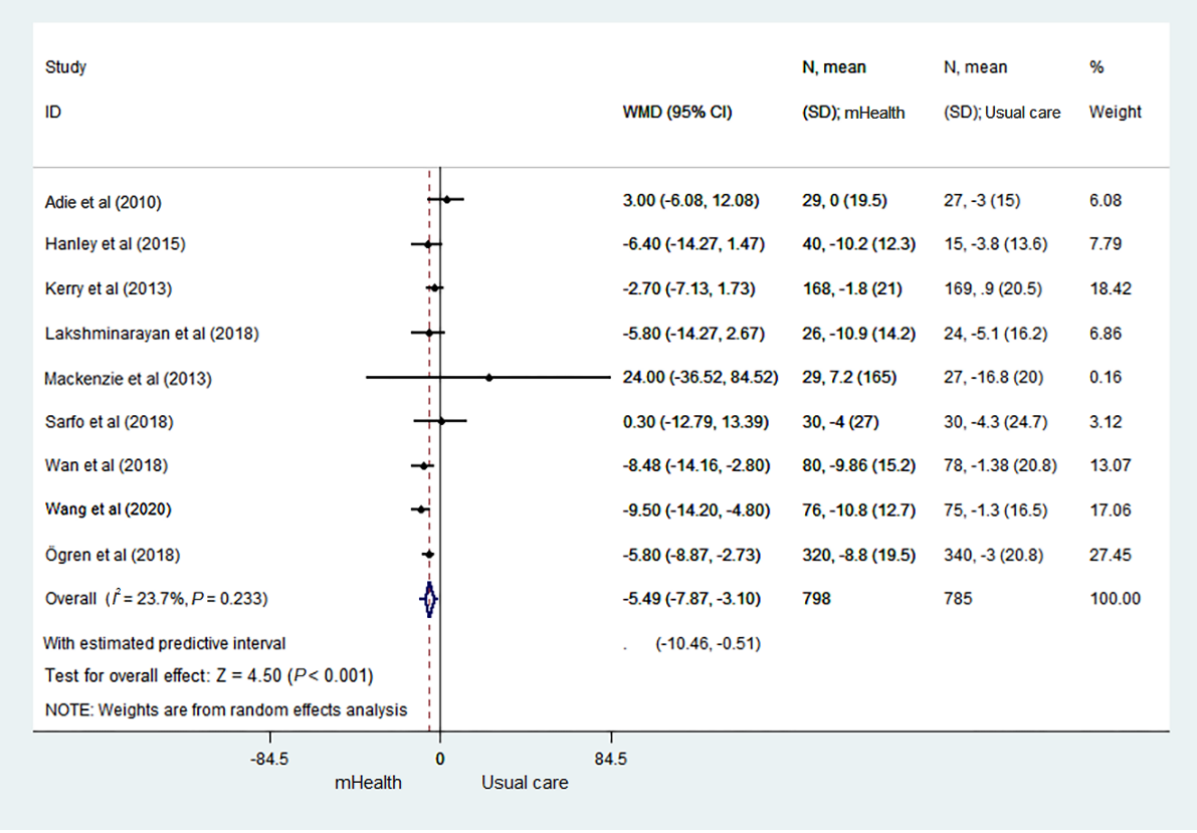
Figure 2. Forest plot of the systolic blood pressure of the telemedicine and mHealth group and usual care group. mHealth: mobile health; WMD: weighted mean